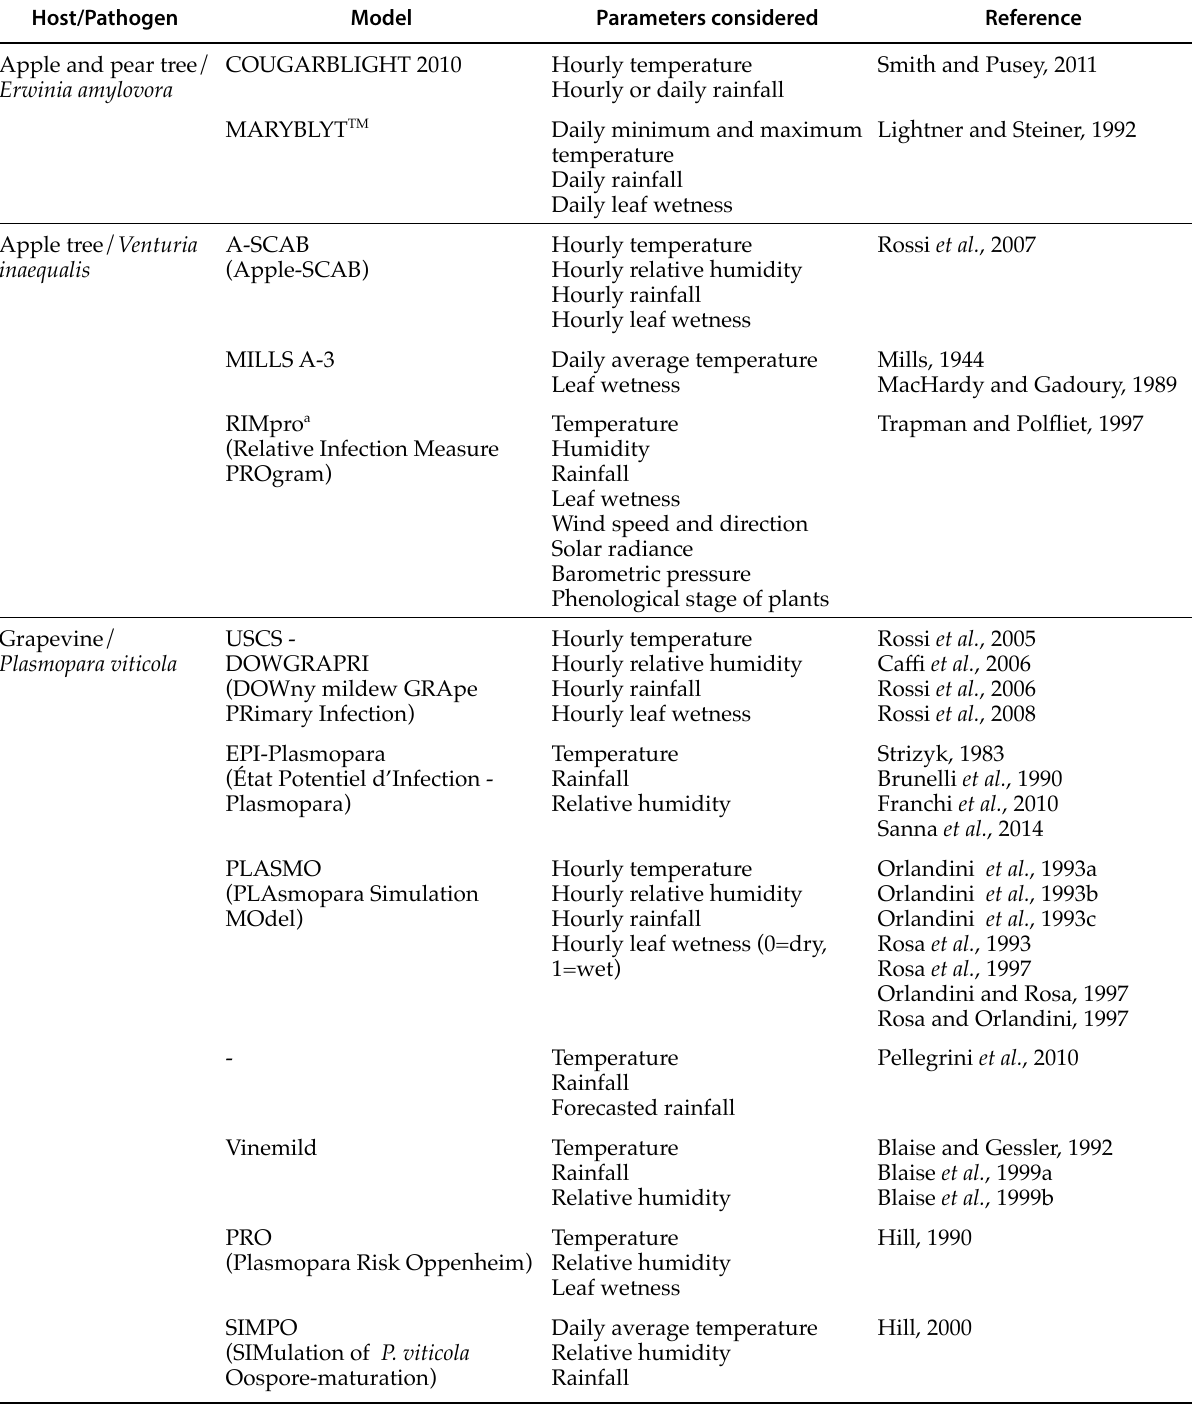
Table 3. Main plant disease forecasting models used to reduce copper